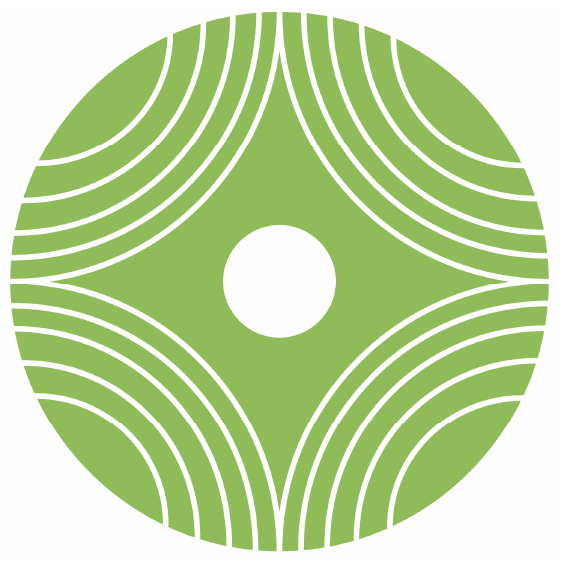
Figure 37. SynRM with axially laminated rotor [23].